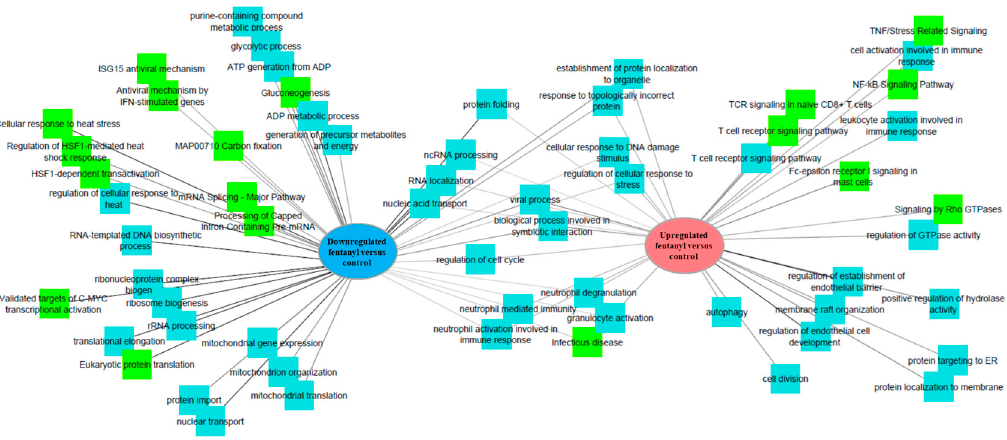
Figure 10. RNAseq analysis of genes that are upregulated (red) or downregulated (blue) in the ACH-2 cell line in the presence/absence of fentanyl.